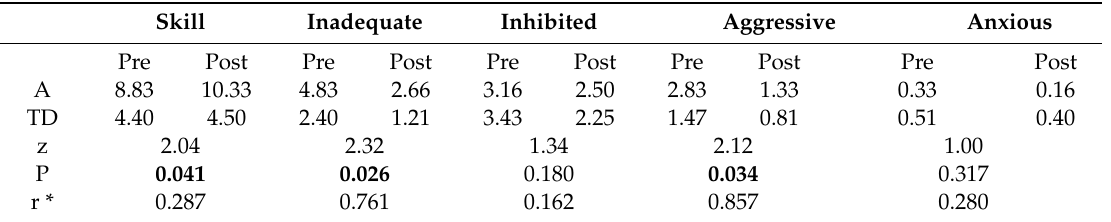
Table 7. Average (A), typical deviations (TD), Wilcoxon test results (Z), significance ( p ), and dMR value (r) of the total number of students in the pre-test and post-test in the social skills test. Skill